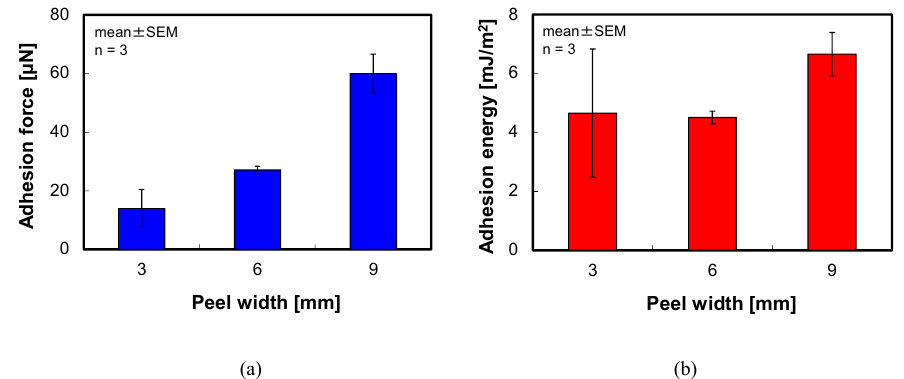
Fig. 7 Adhesion properties of the cell sheet at three peel widths (3 mm, 6 mm and 9 mm): (a) adhesion force and (b) adhesion